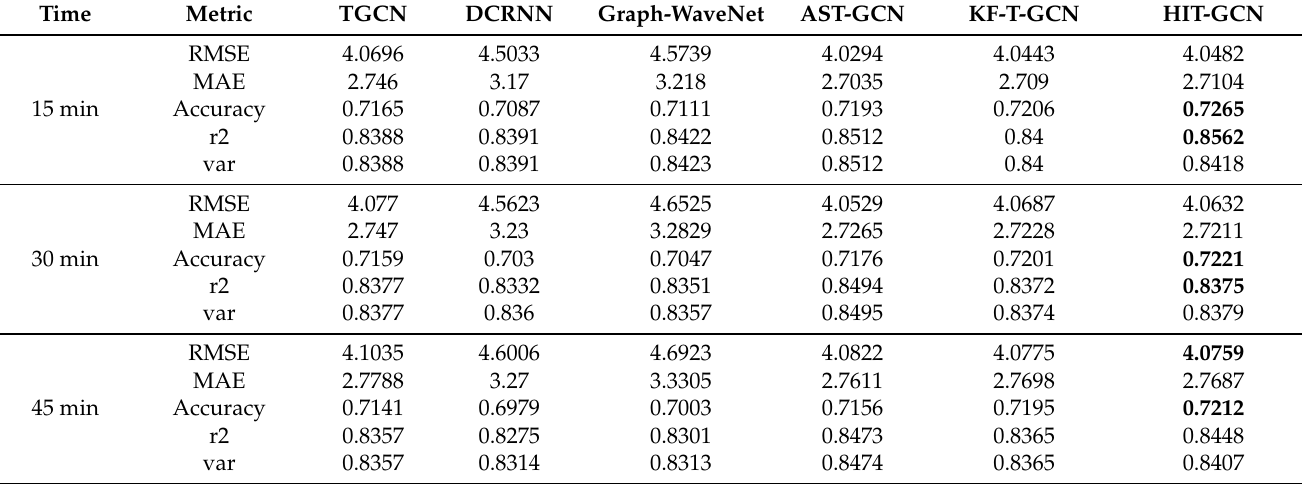
Table 2. 15 min, 30 min, 45 min, 60 min contrast